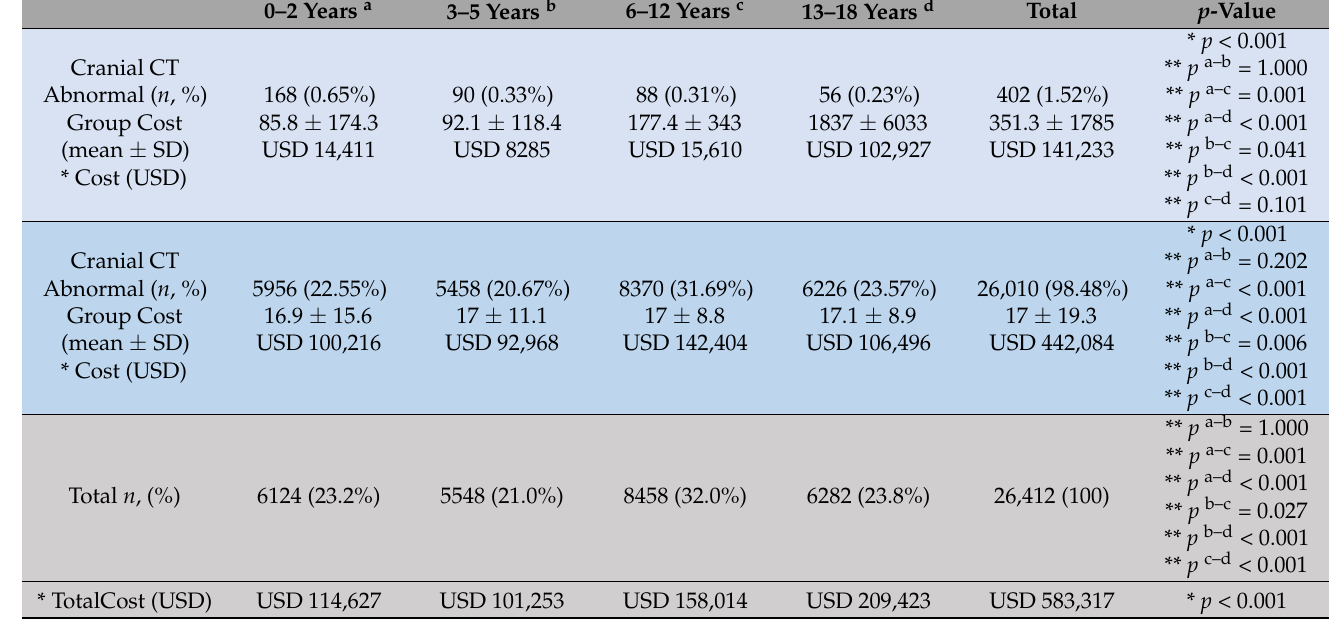
Table 3. Cost-effective analysis with cranial CT according to the age groups of